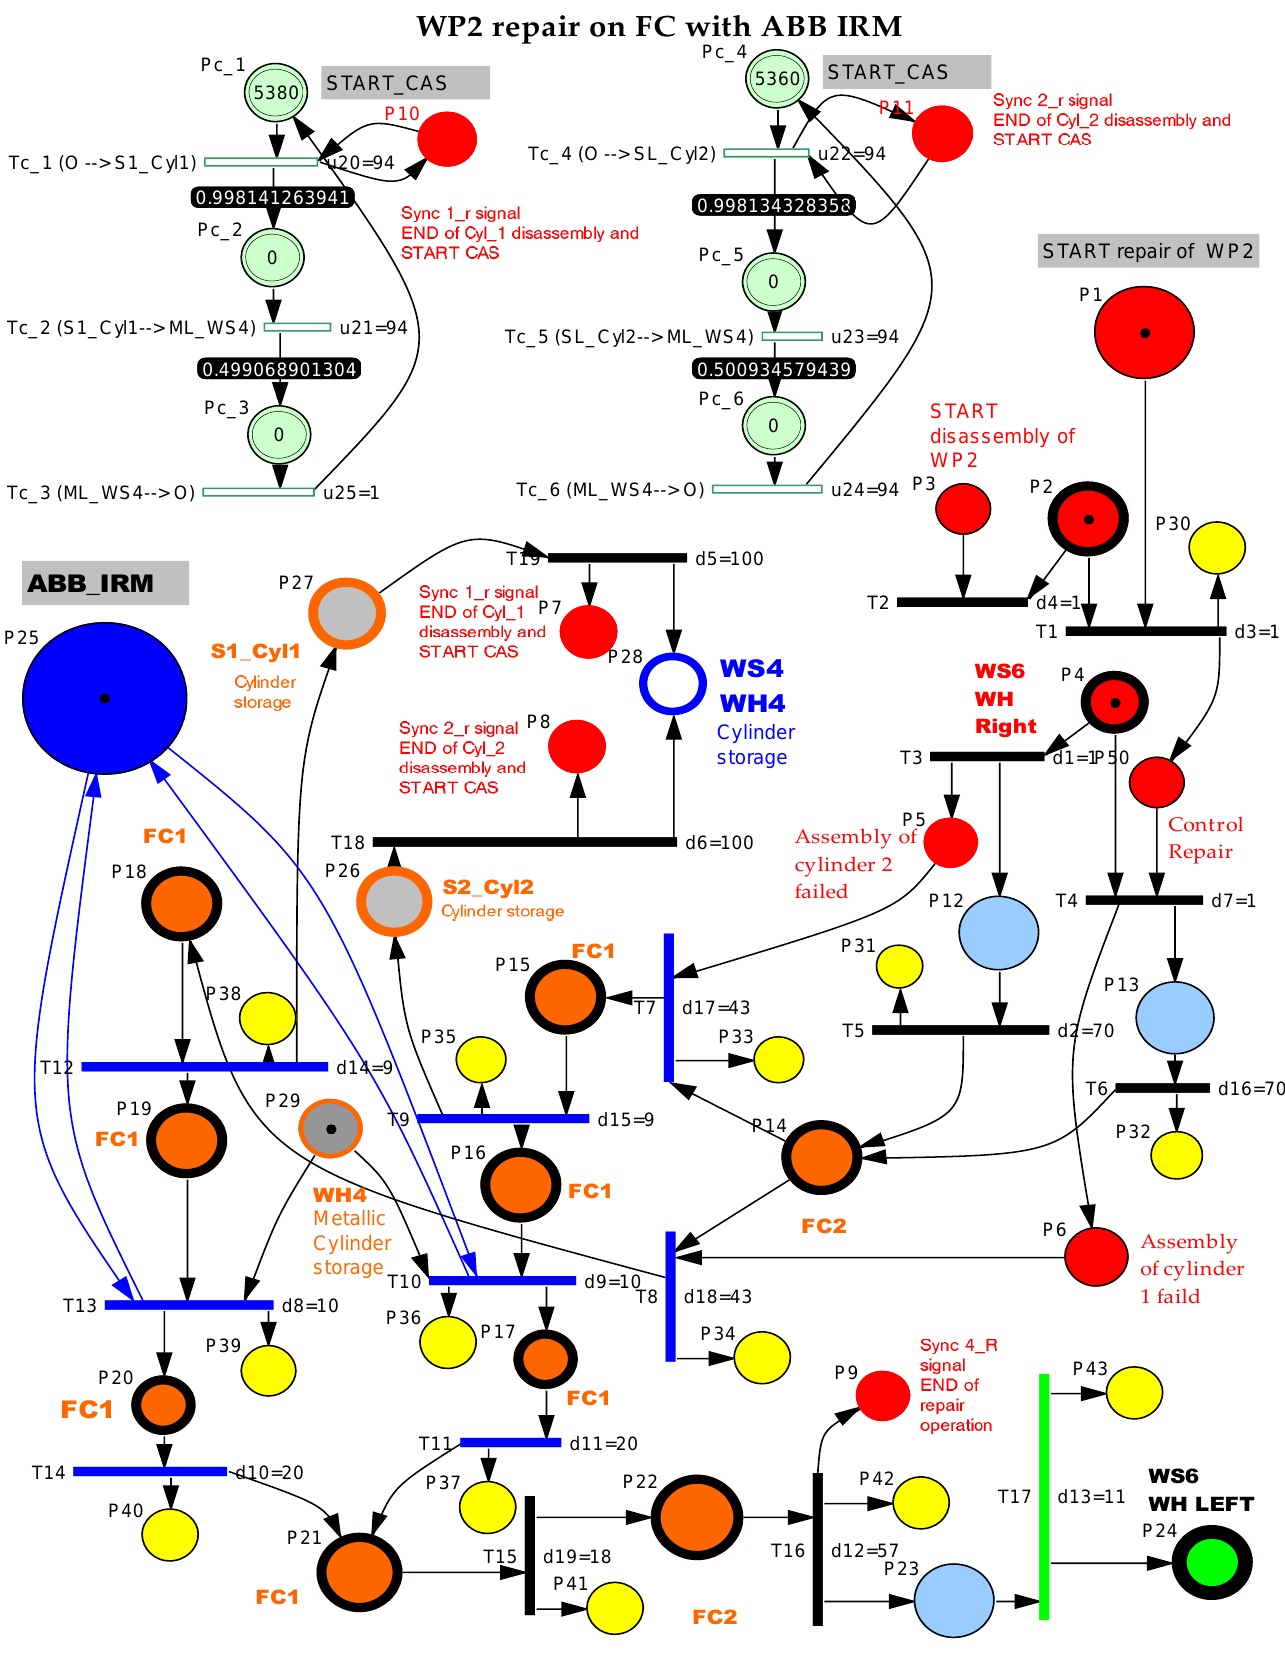
Figure 14. The SHPN_2 model for the repair of the WP2 on FC with ABB IRM.